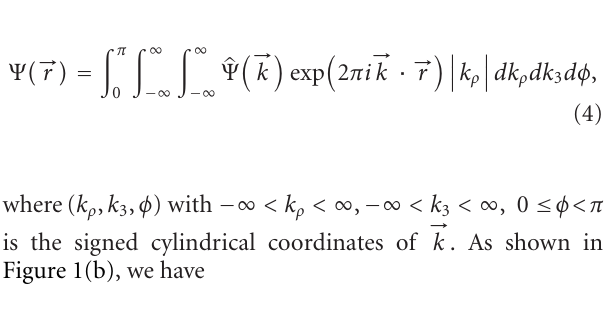
−→ OS moves along the equator from